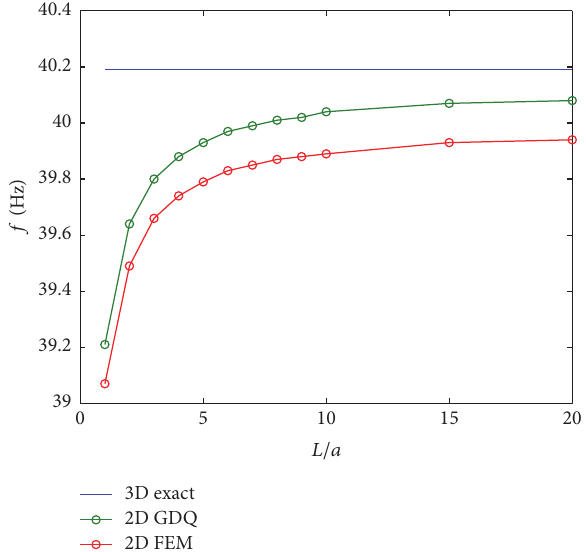
Figure 4: First frequency 𝑓 in Hz for the 𝑎/ℎ = 100 one-layered FGM plate with 𝑝 = 0.5 : convergence of 2D GDQ and 2D FE solutions increasing the length of the simply supported